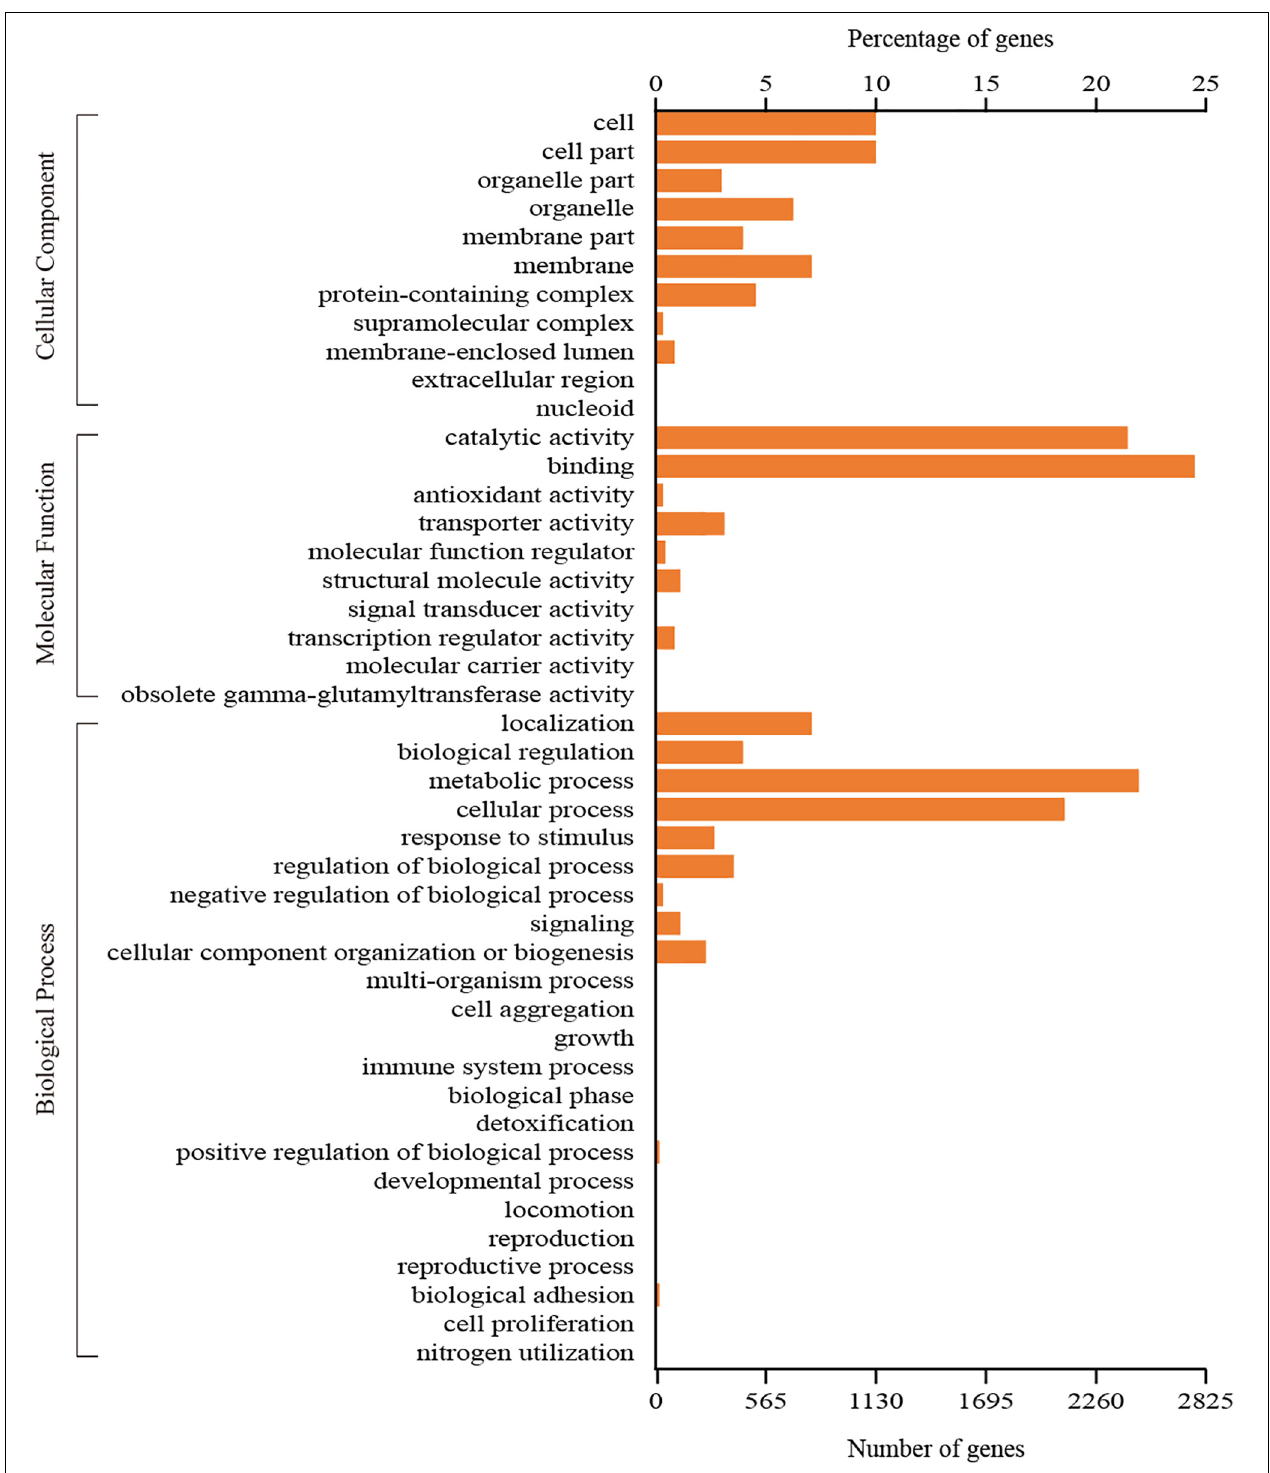
FIGURE 3 | GO classification of all the identified genes in C. oleophila was summarized as three main categories: biological process, molecular function and cellular component.